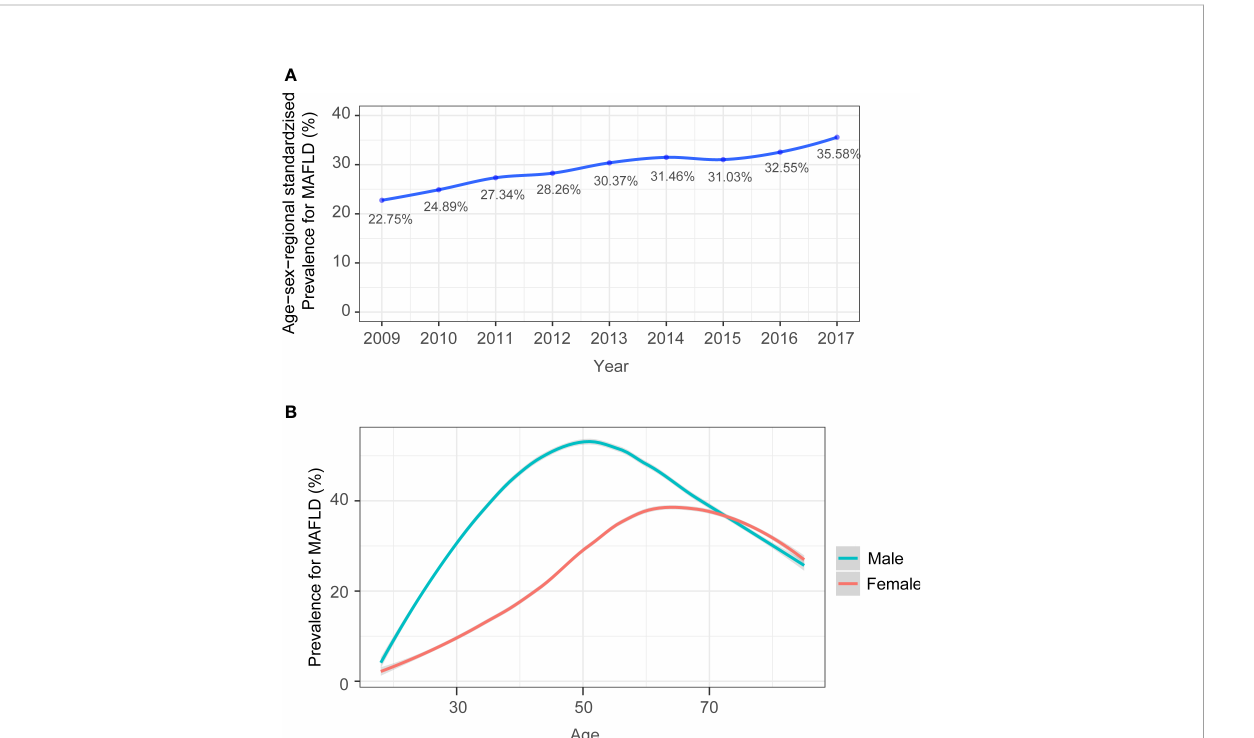
FIGURE 2 (A) Time trend in age, sex, and regional standardized prevalence of MAFLD. Age, sex, and regional standardized prevalence was estimated by using speci fi c weights for subgroups from the sixth national census in 2010. (B) The age-speci fi c prevalence (%) of MAFLD in males and females and in the total population were calculated, with 95% CIs represented by shaded